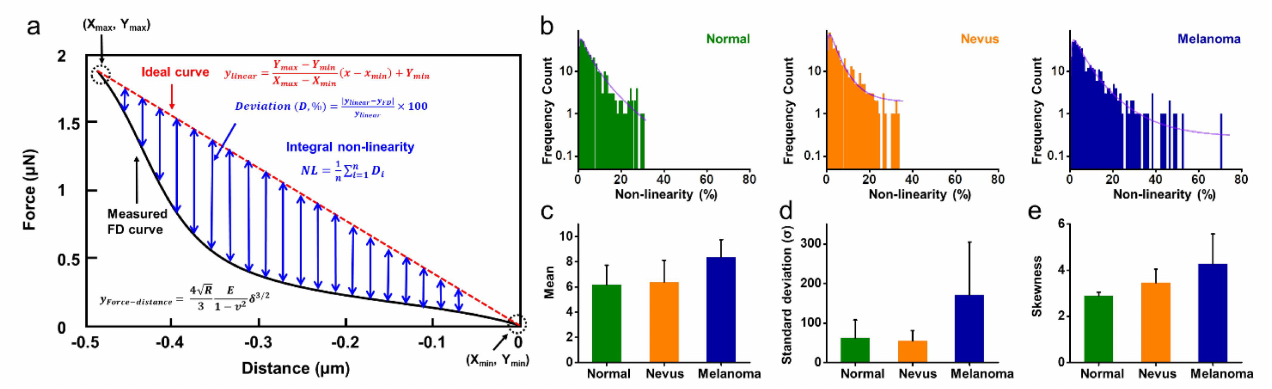
Figure 5. Non-linearity of FD curves of normal, benign nevus, and melanoma specimens. ( a ) Schematic illustration of the calculation of non-linearities. ( b ) The histograms of non-linearity of normal, be- nign nevus, and melanoma specimens were calculated from individual FD curves. The value of ( c ) mean, ( d ) standard deviation, and ( e ) skewness extracted from a model with the inverse Gaussian distribution of the histograms ( b